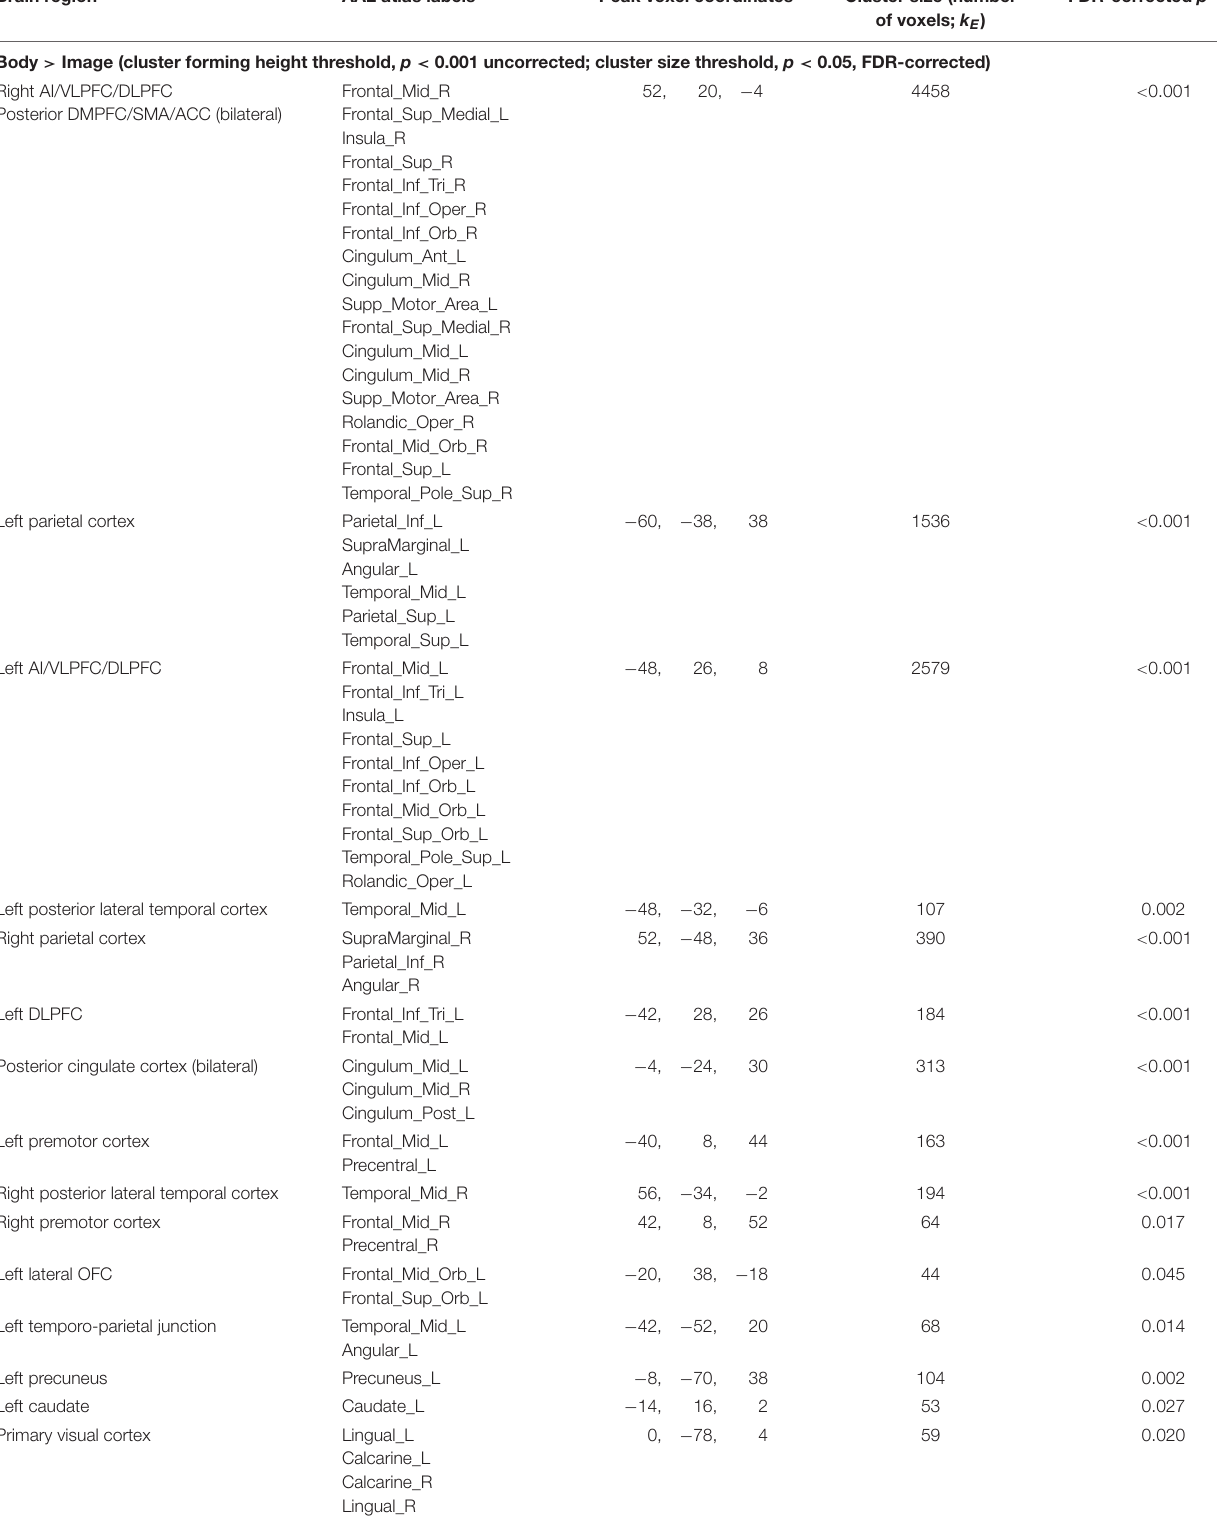
TABLE 3 | fMRI results: body vs. image. Brain region AAL atlas labels Peak voxel coordinates Cluster size (number